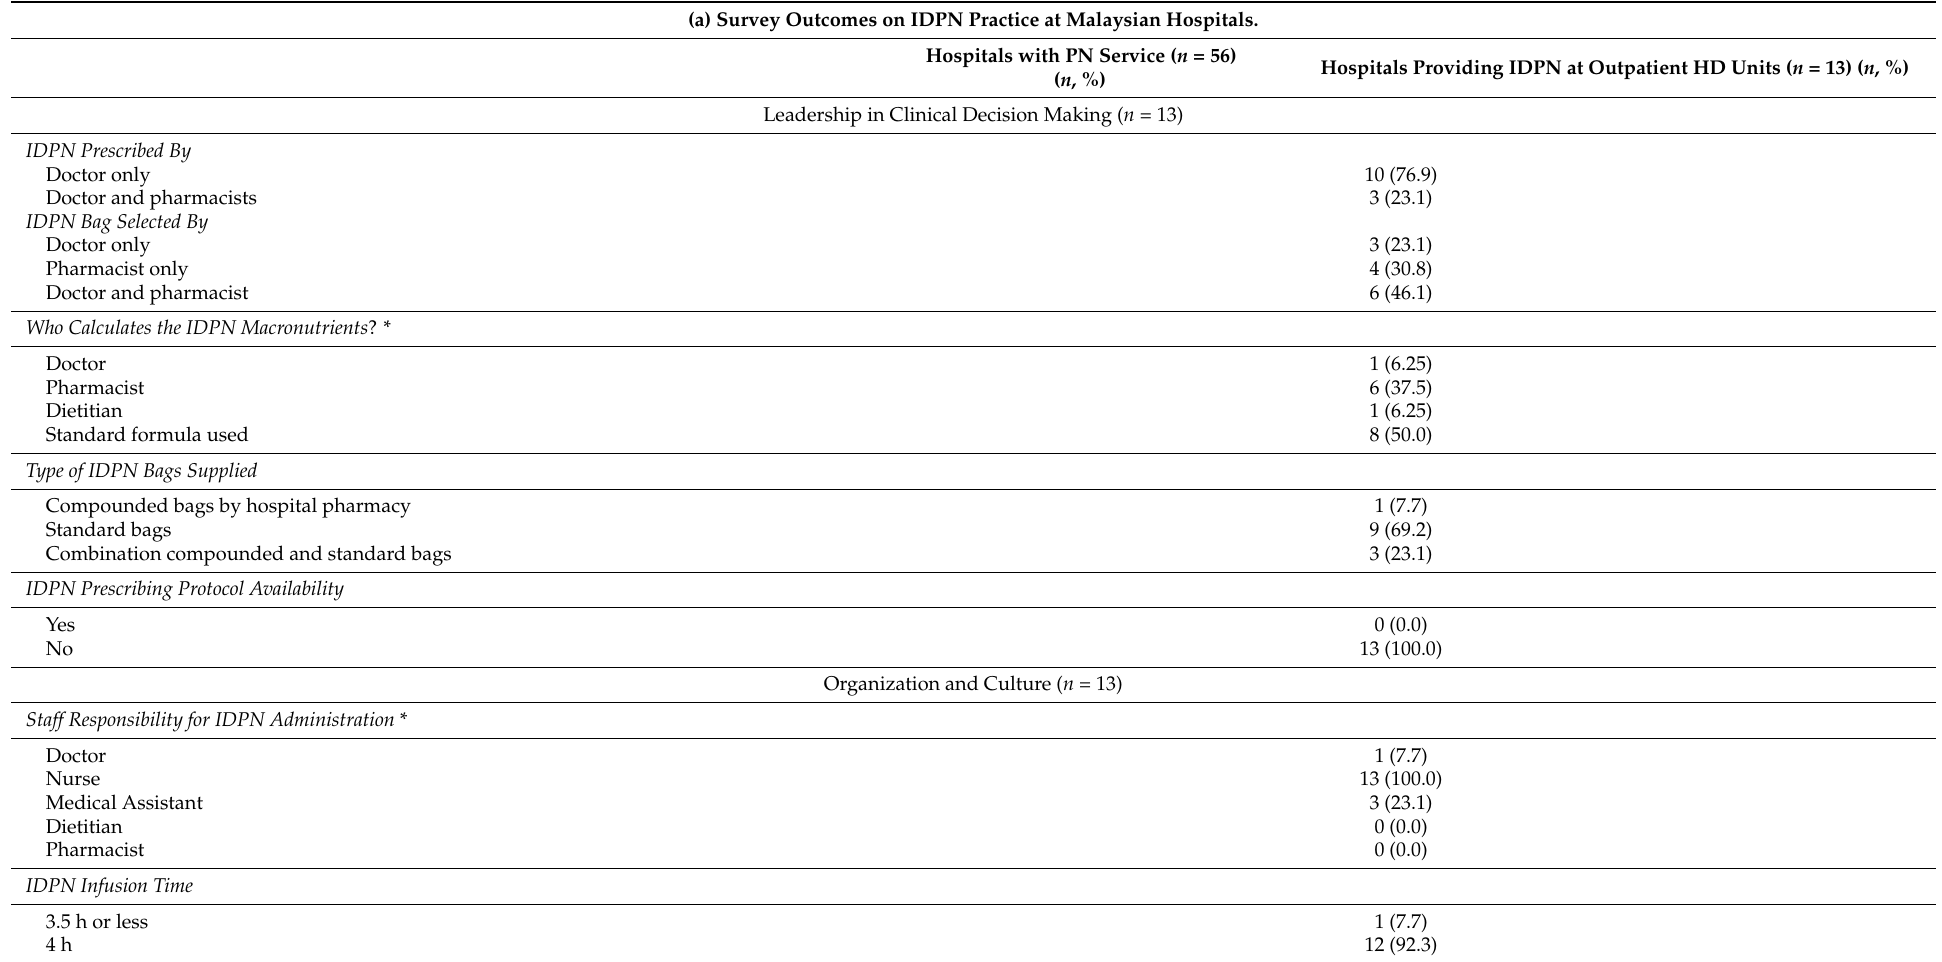
Table 2. Cont . (a) Survey Outcomes on IDPN Practice at Malaysian